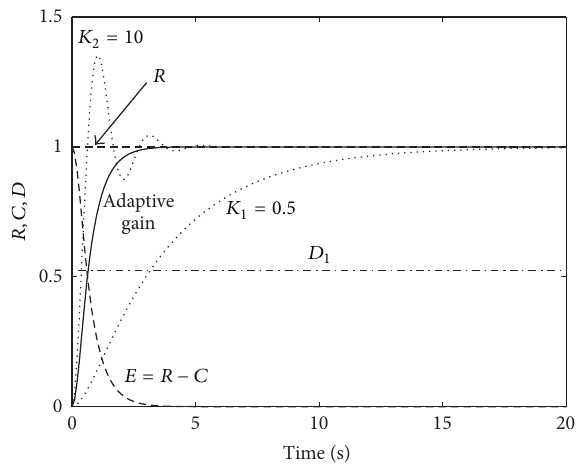
Figure 2: Time responses of the illustrating example for 𝐾 = 0.5 , 10 and adaptive gain.